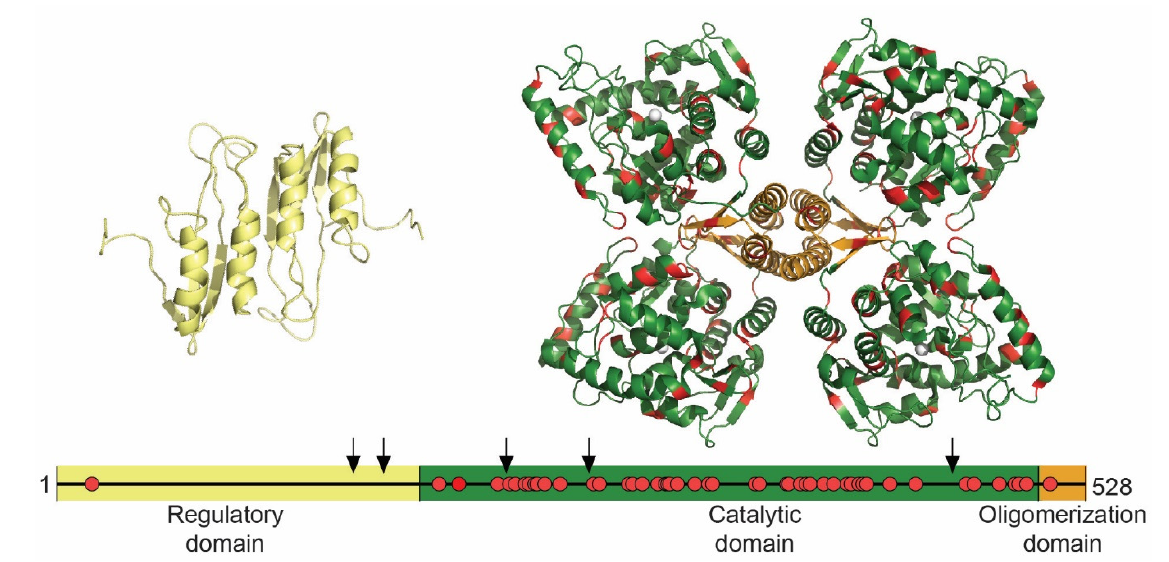
Figure 2. Available TH structures and position of THD mutations. The isolated RD dimer from rat (PDBID 2MDA) [77] (yellow) and the human TH tetramer containing CD (green) and OD (orange) (PDB ID 2XSN). The position of residues with missense mutations registered in PNDdb are shown in red on the structure and on the schematic of the 528 amino acids long TH4. Arrows point to position of nonsense mutations.